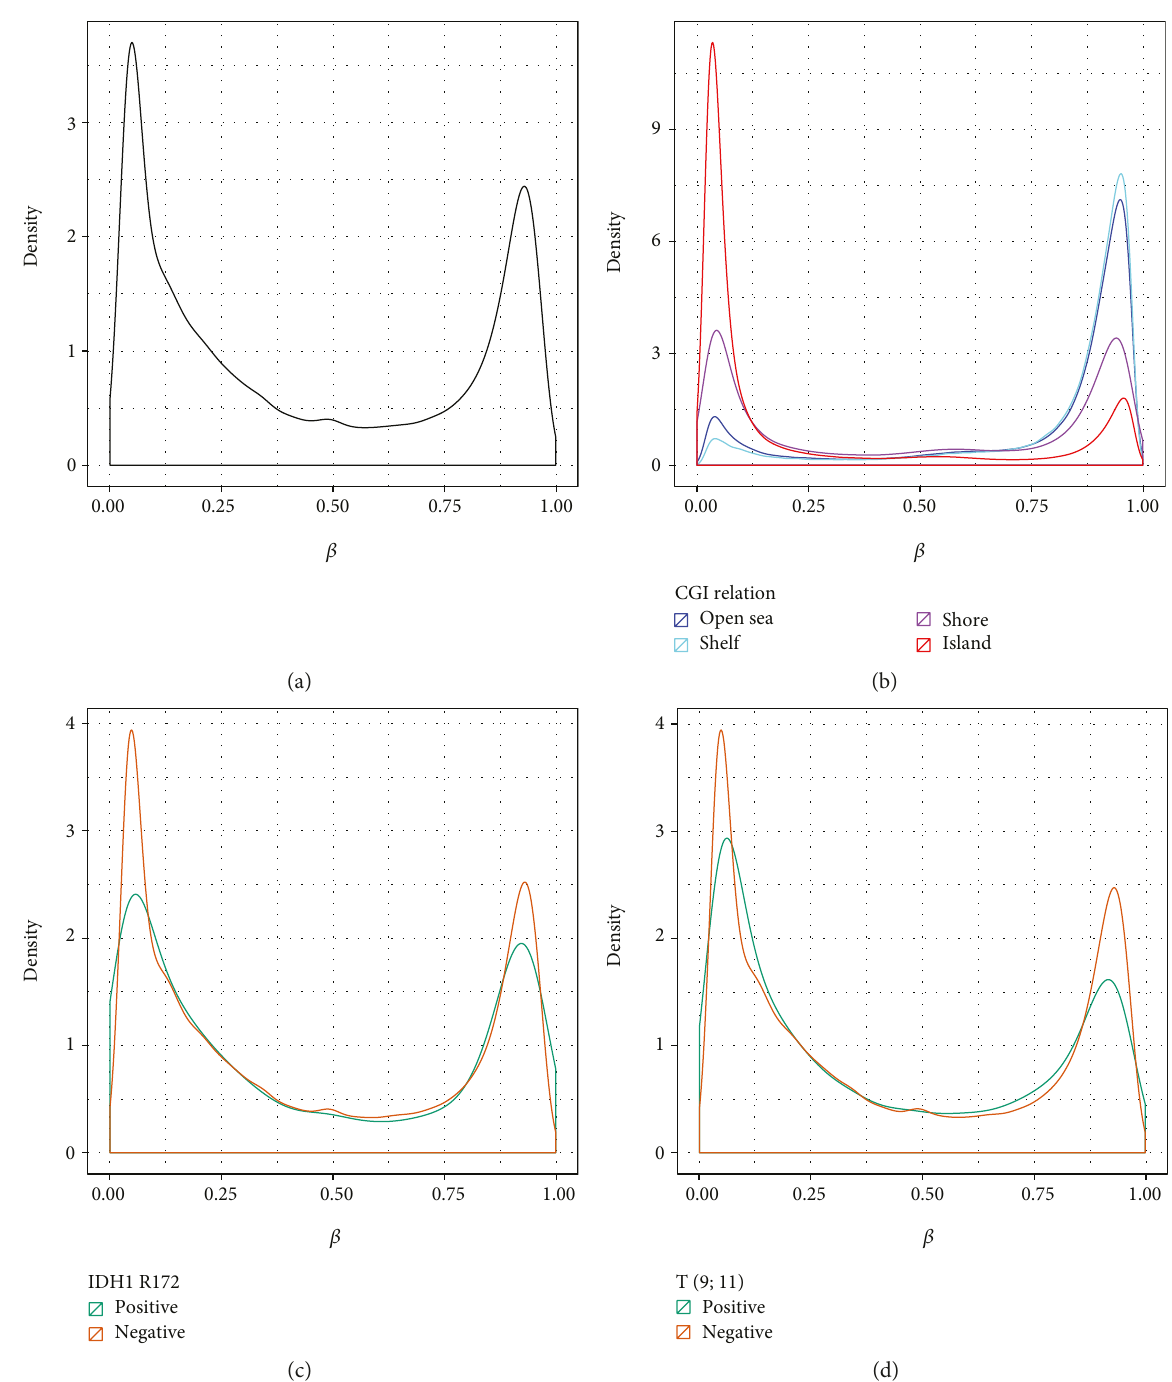
Figure 3: Methylation distribution in genomes. (a) Methylation distribution (beta value) across all promoters that follow bimodal distribution pattern. (b) Methylation value density estimation in all samples at di ff erent CpG region. (c) IDH1 R172-positive and IDH1 R172-negative patient ’ s promoter methylation distribution. Negative patient distribution is similar with (a), but positive patients show lower density. (d) T (9; 11)-positive and T (9; 11)-negative patient ’ s promoter methylation distribution, and here, also positive patients show lower